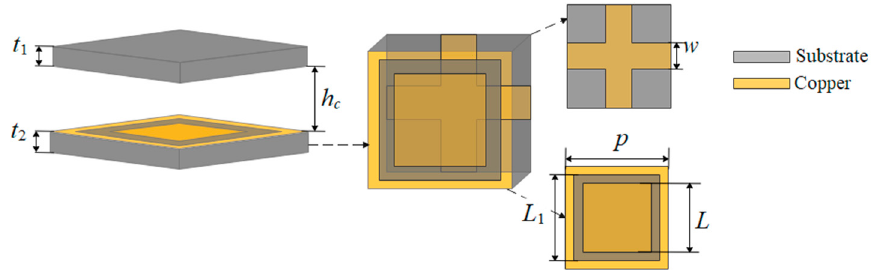
Figure 5. Overall structure of FSS unit.